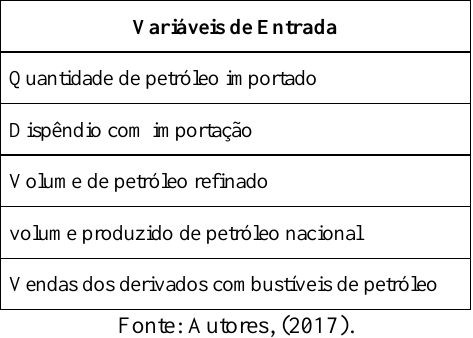
Tabela 1: Variáveis de entrada da rede